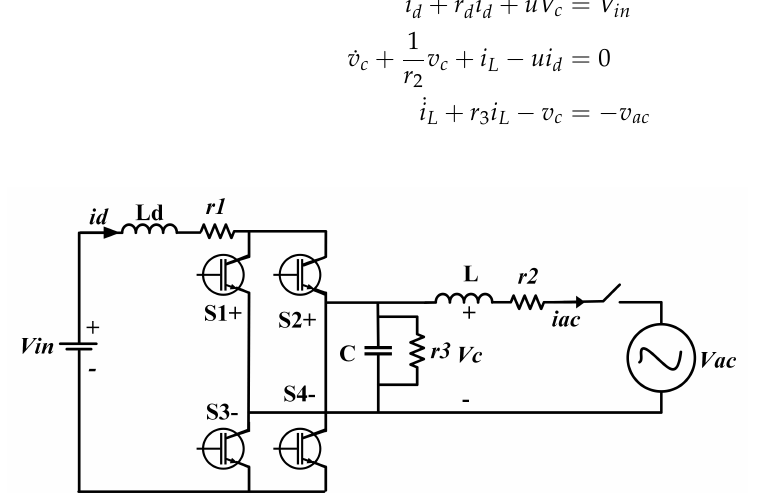
Figure 13. Typical